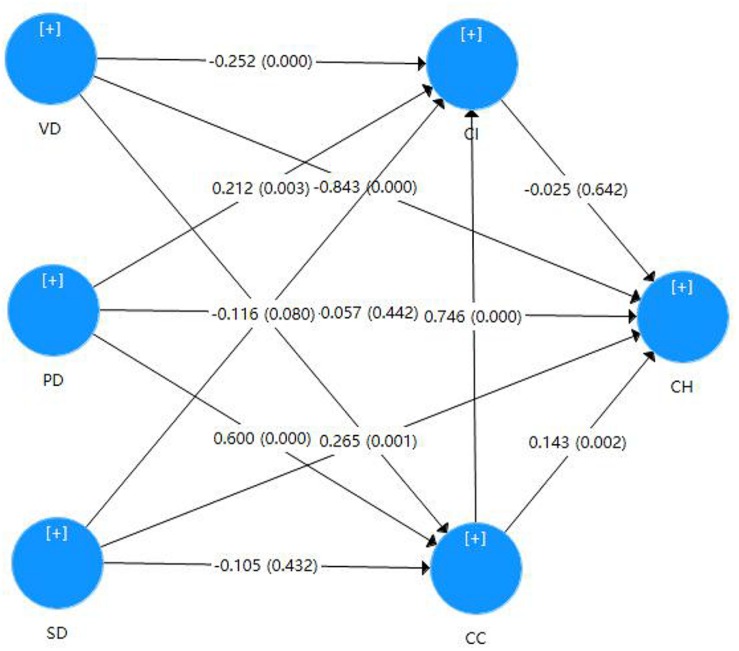
Resultsof the model.